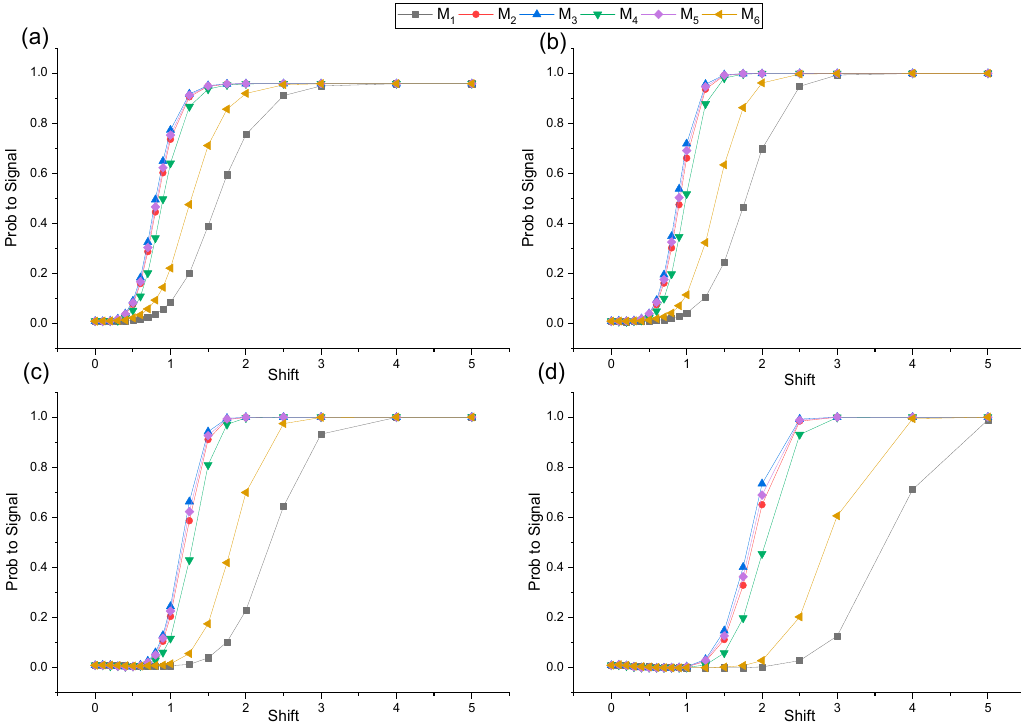
Figure 5. Probability to signal plot for different auxiliary information based median charts using 𝑛 = 10 , 𝑚 = 30 , 𝜌 = 0.95 and 𝛼 = 0.01 at ( a ) 𝑚 (cid:2869) = 3, ( b ) 𝑚 (cid:2869) = 6, ( c ) 𝑚 (cid:2869) = 9, ( d ) 𝑚 (cid:2869) = 12.